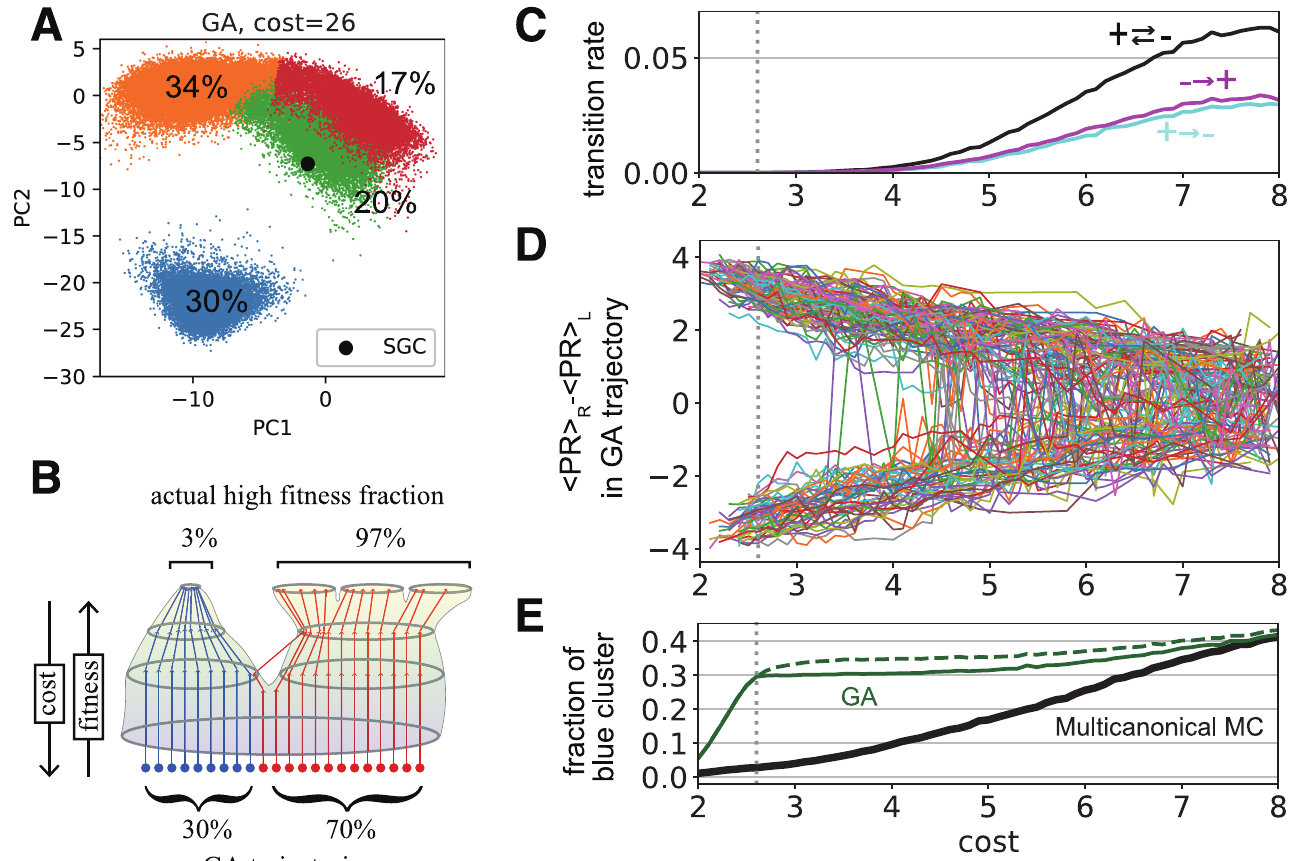
Fig 3. Simulation results by genetic algorithms (GAs). Results of 10 5 independent GAs. (A) Codes with comparable cost values to the SGC, 2.6 − Δ < cost < 2.6 + Δ ( Δ = 0.1), on the same PC1-PC2 plane as in Fig 2. Clustering was performed based on samples with cost < 2.6 + Δ , obtained via GA and MCMC sampling. (B) Schematic illustration of evolution under the multipeak fitness landscape. (C-E) Analysis of the independent GA trajectories. The cost values of the independent GA runs are plotted on the horizontal axis. (C) Transition rates from Δ > 0 to Δ < 0 (cyan), from Δ < 0 to Δ > 0 (purple), and between Δ PR PR PR PR PR > 0 and Δ PR < 0 (black), where Δ PR is the difference in polar requirement between left and right two columns of code: Δ PR = h PR i R − h PR i L . (D) Δ PR in GA trajectories as a function of the cost value experienced in each GA. Note that if a trajectory experiences the same cost value multiple times, only the latest value is recorded, so a single curve is always a univalent function and does not necessarily correspond to the GA time series (GA time series can go up and down in cost). (E) Fraction of genetic codes with Δ < 0. The green dashed line depicts the fraction for all the GA trajectories, while the thick line indicates that for GA PR trajectories conditioned to reach cost = 2.6.